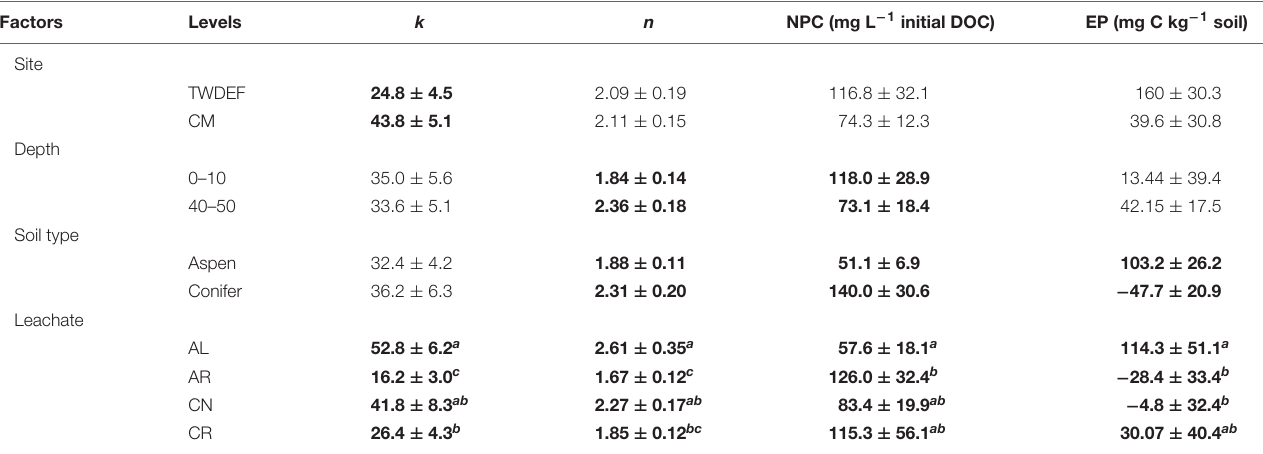
TABLE 4 | Average values ± standard error of the mean of calculated parameters for each level of each main effect (Bolding indicates statistically significant differences at α = 0.05; letters indicate differences between levels of a factor). Factors